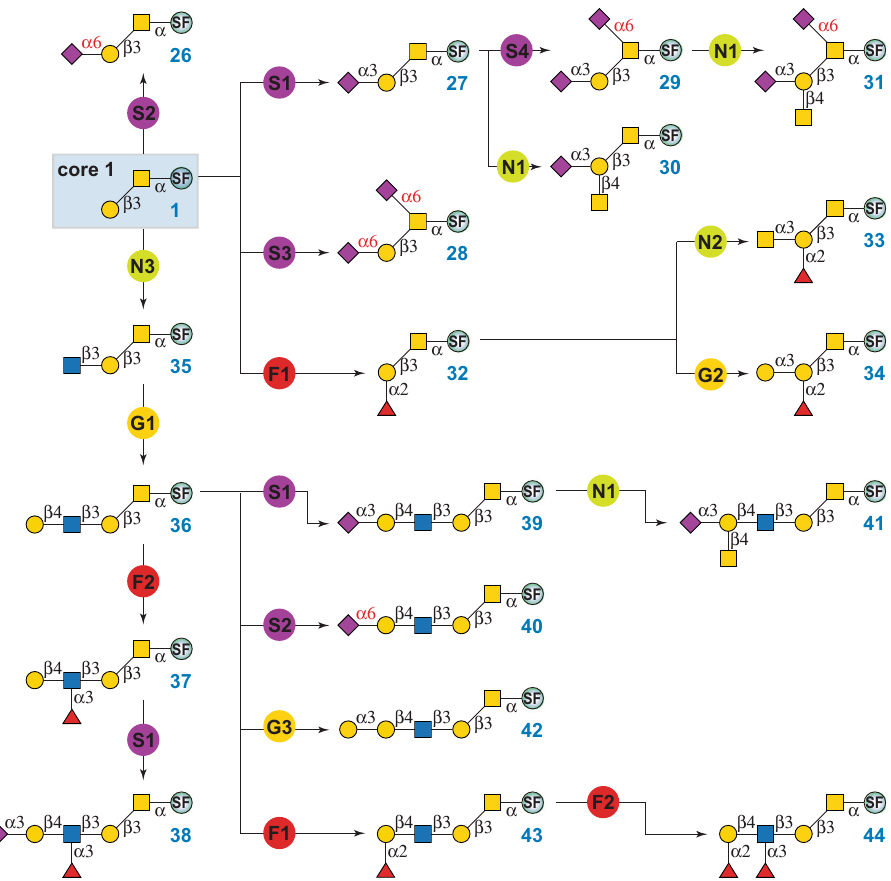
Fig. 4 Enzymatic modular synthesis of core 1 O-GalNAc glycans. G1: β 1-4 galactosylation with NmLgtB and UDP-Gal; G2: α 1-3 galactosylation with human GTB and UDP-Gal; G3: α 1-3 galactosylation with B α 3GalT and UDP-Gal; S1: α 2-3 sialylation with PmST1-M144D, NmCSS, CTP, and Neu5Ac; S2: α 2-6 sialylation with PmST1-P34H/M144L, NmCSS, CTP, and Neu5Ac; S3: α 2-6 sialylation with Pd2,6ST, NmCSS, CTP, and Neu5Ac; S4: α 2-6 sialylation with human ST6GalNAc-IV, NmCSS, CTP, and Neu5Ac; N1: β 1-4 N -acetylgalactosaminylation with CjCgtA and UDP-GalNAc; N2: α 1-3 N - acetylgalactosaminylation with HmBgtA and UDP-GalNAc; N3: β 1-3 N -acetylglucosaminylation with HpLgtA and UDP-GlcNAc; F1: α 1-2 fucosylation with Hm2FT and GDP-Fuc; F2: α 1-3 fucosylation with Hp3FT and GDP-Fuc. SF, Fmoc protected